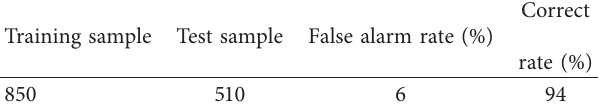
Table 2: RBF neural network test results.